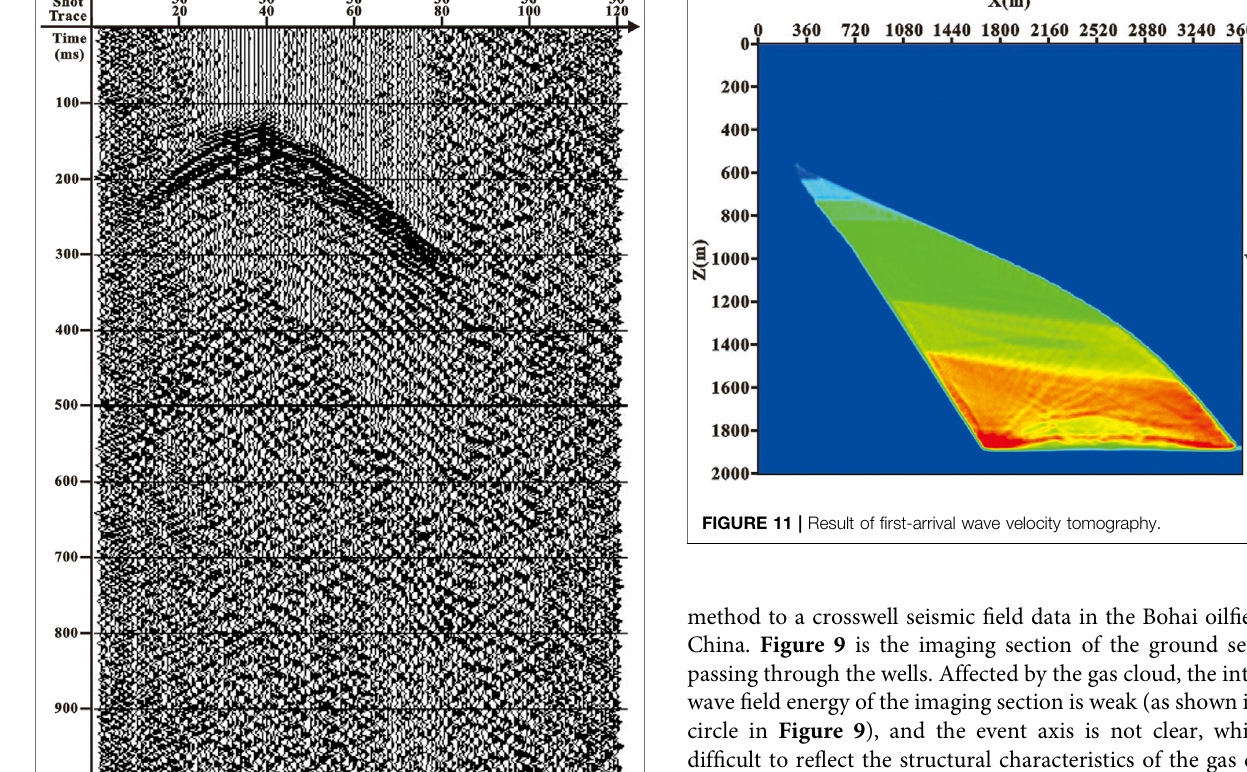
Figure 5 . It can be seen from the fi gure that the fi rst-arrival wave